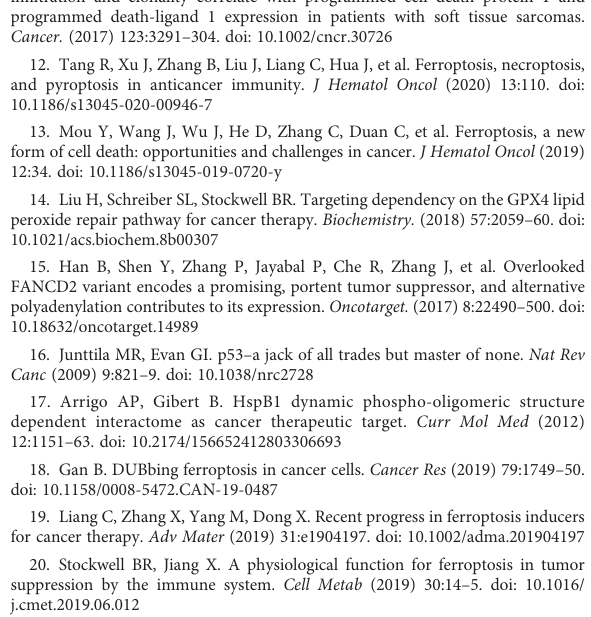
SUPPLEMENTARY FIGURE 6 Single cell sequencing analysis of metastatic OS samples. (A) UMAP visualized 13 cell subclusters identi fi ed in metastatic OS samples using “ FindClusters ” function. (B) Heatmap of top10 feature genes in the 13 subclusters. Yellow represents high expression level of genes, purple represents low expression. (C) Expression of eight risk signature genes in allidenti fi edcells. Purplerepresentshighexpression ofsignaturegenes. The more purple the color, the higher the expression. (D) Expression proportion of eight signature genes among all detected cells in metastatic OS samples. Red represents the proportion of gene-positive cells and blue represents the proportion of gene-negative cells. (E) UMAP visualization exhibits 10 annotated cell clusters based on metastatic OS single cell sequencing. (F) Risk cell clustering by ferroptosis signature clusters all cells into high-risk cells and low-risk cells. Red represents high-risk cells and blue represents low-risk cells. NA represents partial signature genes were not expressed in the single-cell sparse matrix. SUPPLEMENTARY FIGURE 7 Single cell sequencing analysis of recurrent OS samples. (A) UMAP visualized 13 cell subclusters identi fi ed in recurrent OS samples using “ FindClusters ” function. (B) Heatmap of top10 feature genes in the 13 subclusters. Yellow represents high expression level of genes; purple represents low expression. (C) Expression of eight risk signature genes in allidenti fi edcells. Purplerepresentshighexpression ofsignaturegenes. The more purple the color, the higher the expression. (D) Expression proportion of eight signature genes among all detected cells in recurrent OS samples. Red represents the proportion of gene-positive cells and blue represents the proportion of gene-negative cells. (E) UMAP visualization exhibits 6 annotated cell clusters based on recurrent OS single cell sequencing. (F) Risk cell clustering by ferroptosis signature clusters all cells into high-risk cells and low-risk